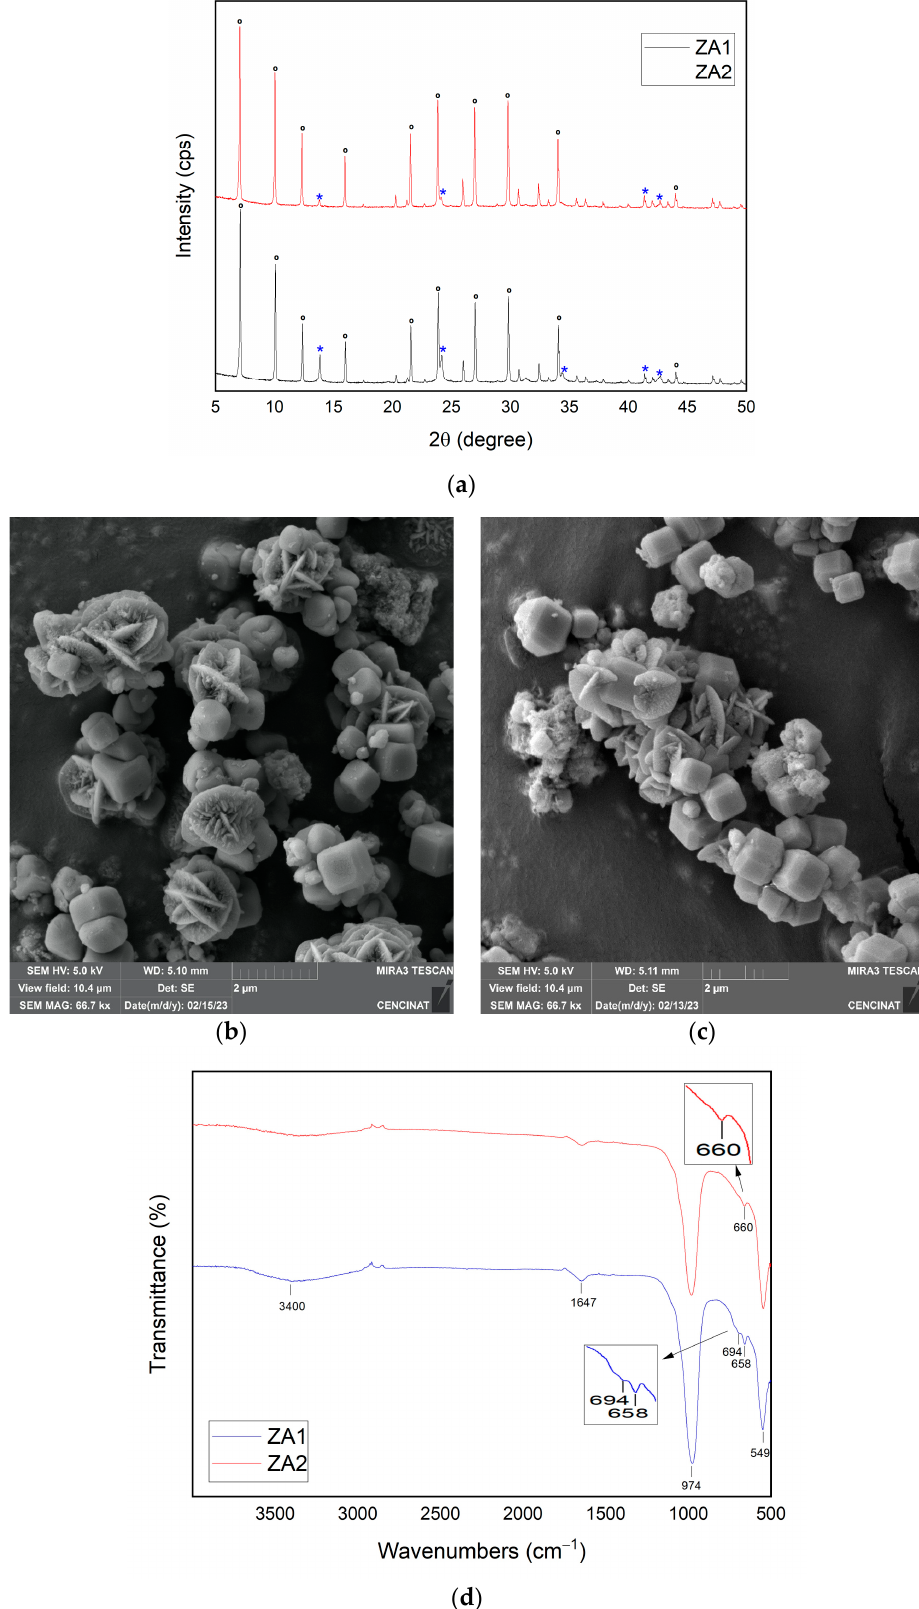
Figure 2. XRD pa tt erns of synthesized zeolites ZA1 and ZA2 ( a ), * sodalite and ° LTA). SEM micro- Figure 2. XRD patterns of synthesized zeolites ZA1 and ZA2 ( a ), * sodalite and ◦ LTA. SEM micro- graphs of ( b ) ZA1 and ( c ) ZA2. FTIR spectra for ZA1 and ZA2 ( d ). graphs of ( b ) ZA1 and ( c ) ZA2. FTIR spectra for ZA1 and ZA2 ( d